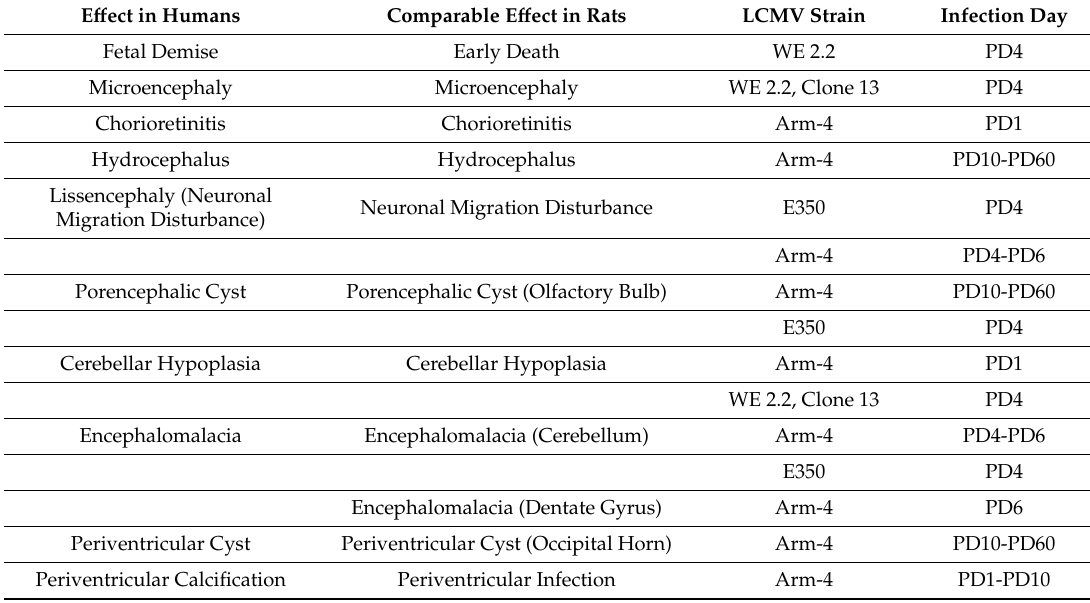
Table 1. Fidelity of the Neonatal Rat Model to Human Congenital LCMV